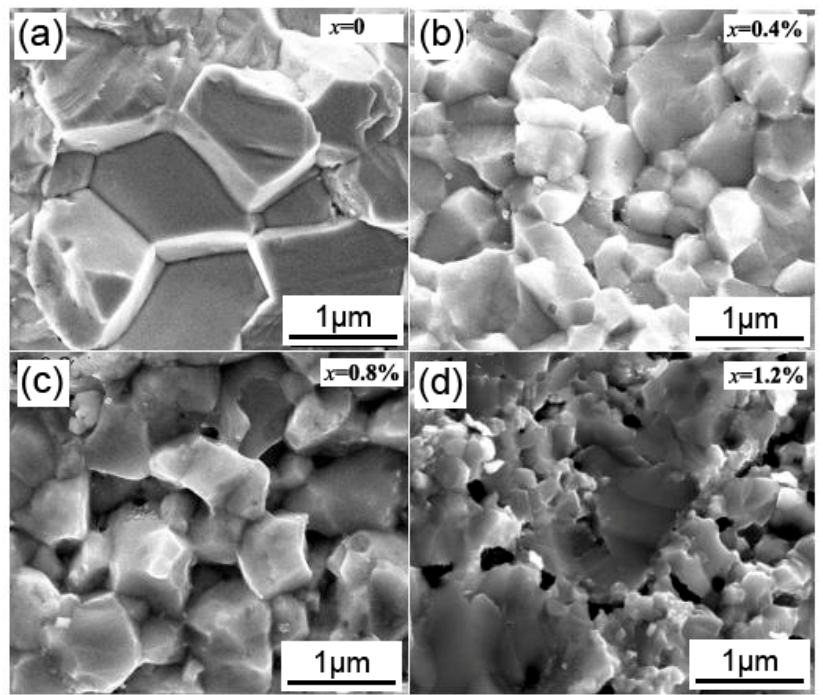
2 SnSe 3 composites. Metals 2019 , 9 , x FOR PEER REVIEW